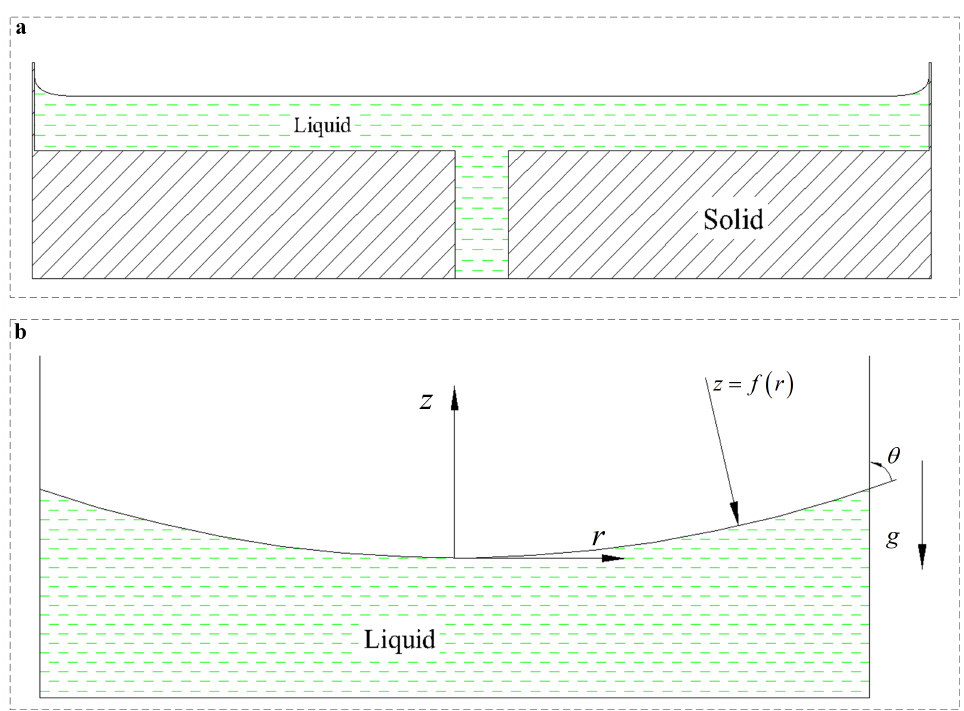
Figure 6. ( a ) The casting model; ( b ) physical parameter configuration of the